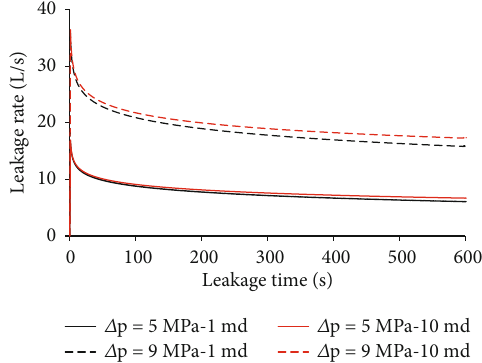
Figure 20: Leakage rate under di ff erent formation permeability and well bottom di ff erential